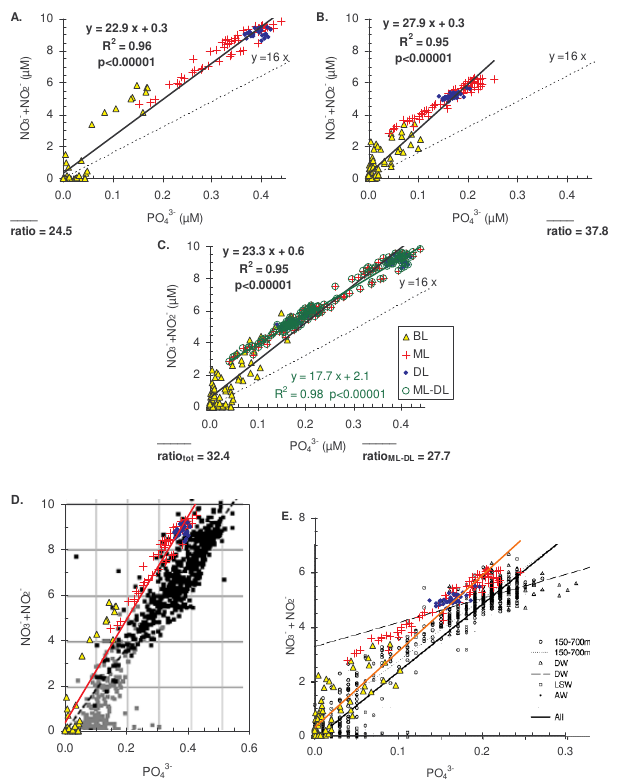
Fig. 8. Plots, linear relationships and probabilities for the slope be- tween NO − +NO − and PO 3 − in (A) the western basin, (B) the east- 3 2 4 ern basin, and (C) the whole Mediterranean Sea, during the BOUM Cruise. Data are separated for the three layers defined in the text, BL, ML and DL. The Redfield value ( y = 16 x ) is indicated by the dashed line. For (C) , data for BL have been excluded (ML-DL) to give rise to the second linear equation ( y = 17 . 7 x + 2 . 1). The aver- age ratio for data a given at the bottom of each graph. (D) Superpo- sition of graph (A) and Fig. 2f redraw from Schroeder et al. (2010) (data from the MEDOCC05 survey). (E) Superposition of graph (B) and Fig. 5 redraw from Kress and Herut (2001) (data from the POEM-Oc91 survey).